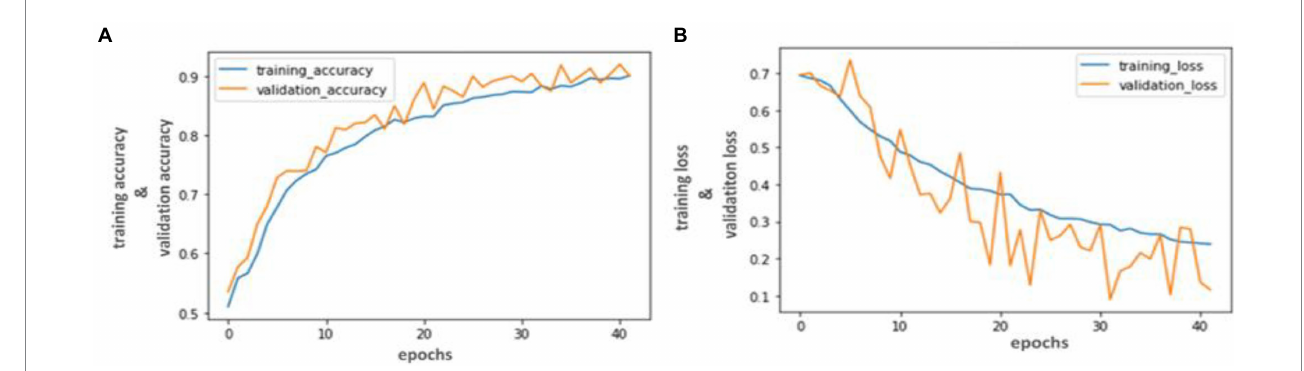
FIGURE 4 Accuracy and Loss graph using the RCNN. (A) representing the training and validation accuracy while (B) representing the training and validation loss of RCNN model according to our dataset.